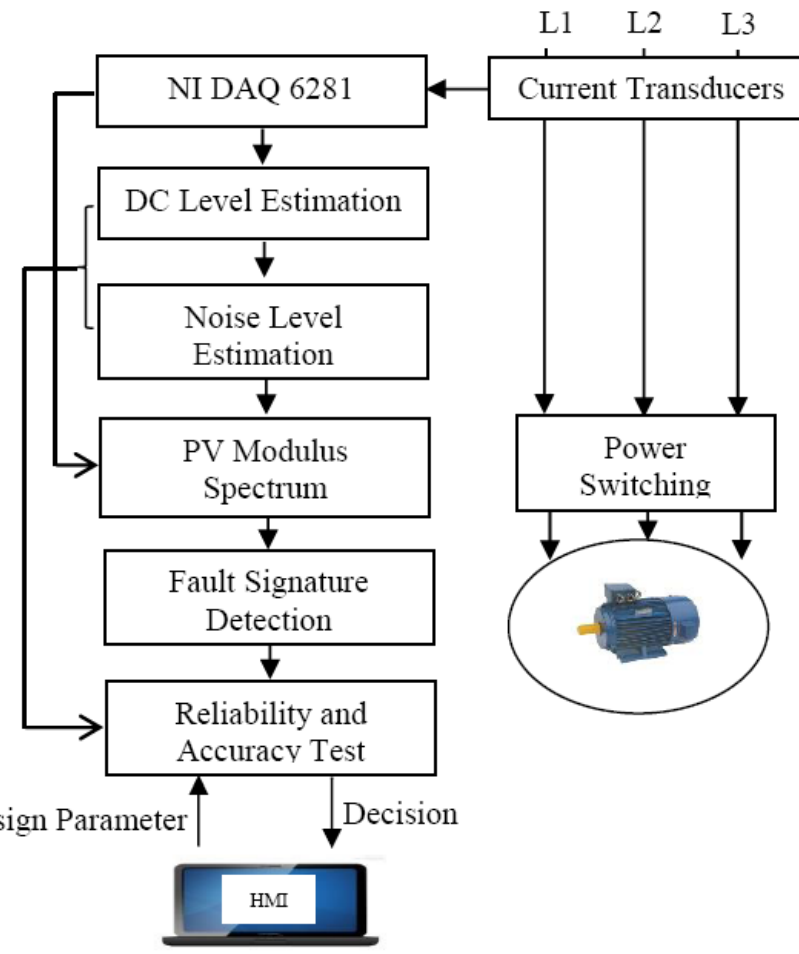
Figure 3. The block diagram of the developed system.